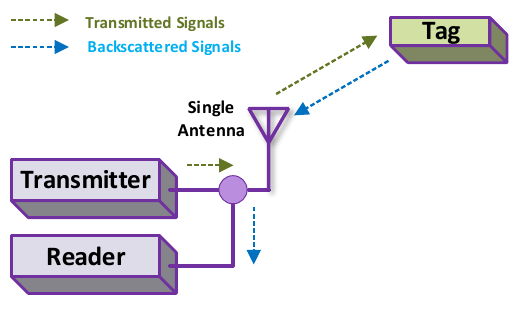
Figure 10. Monostatic